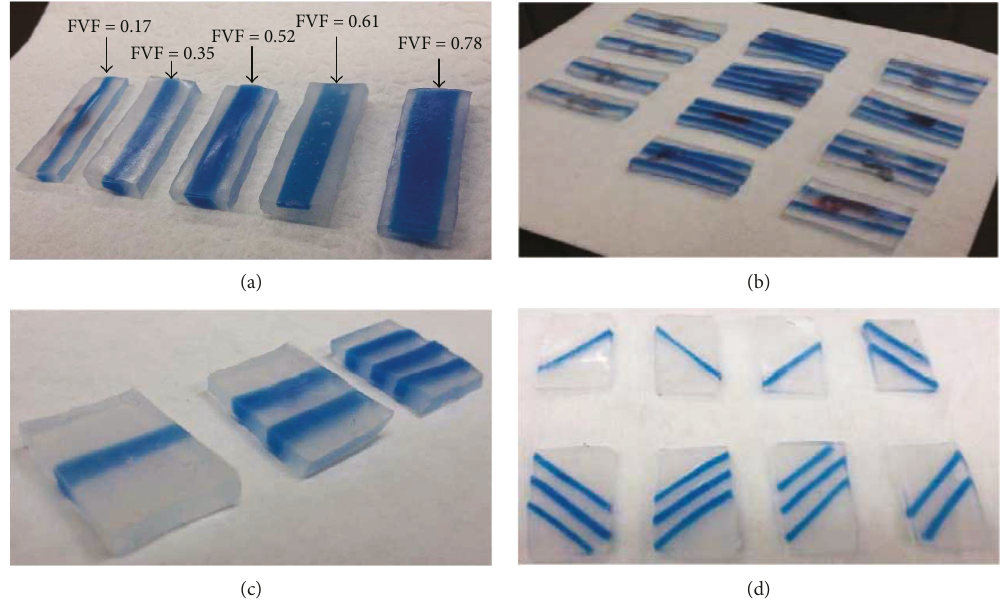
Figure 4: Composite test specimens with (a) varying fi ber volume fractions (FVF), (b) one, two, or three similar fi bers, (c) transverse fi bers, and (d) skewed fi bers at ± 45 °